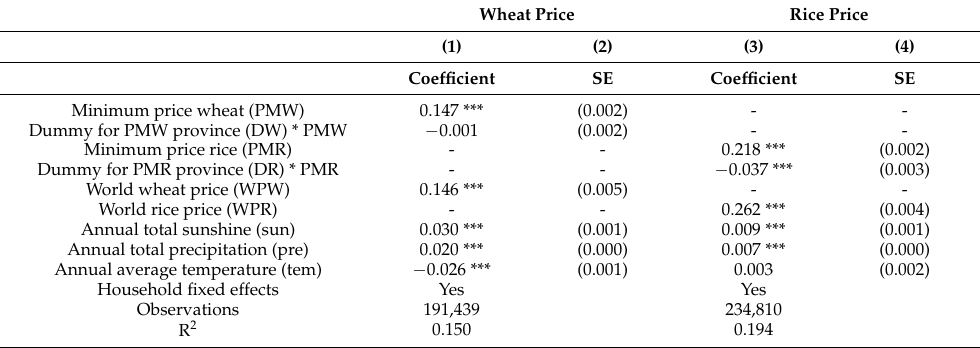
Table 3. Fixed effects regression results for wheat and rice